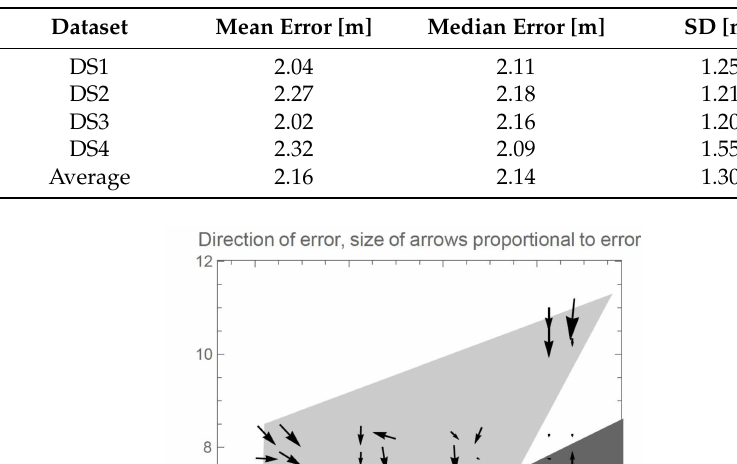
Table 3. Comparison of the mean and median errors made by MFAM method combining WiFi (2.4 GHz) and HomeMatic (868 MHz) signals.